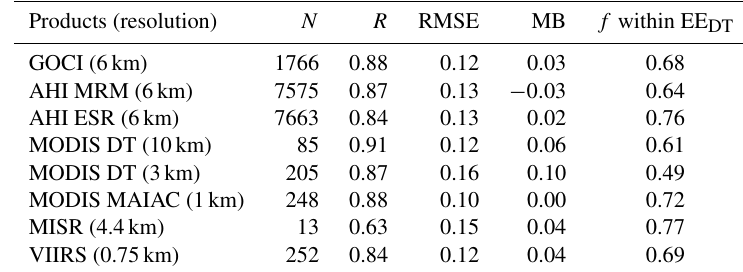
Table 5. Validation statistics for ocean AOD products using AERONET.